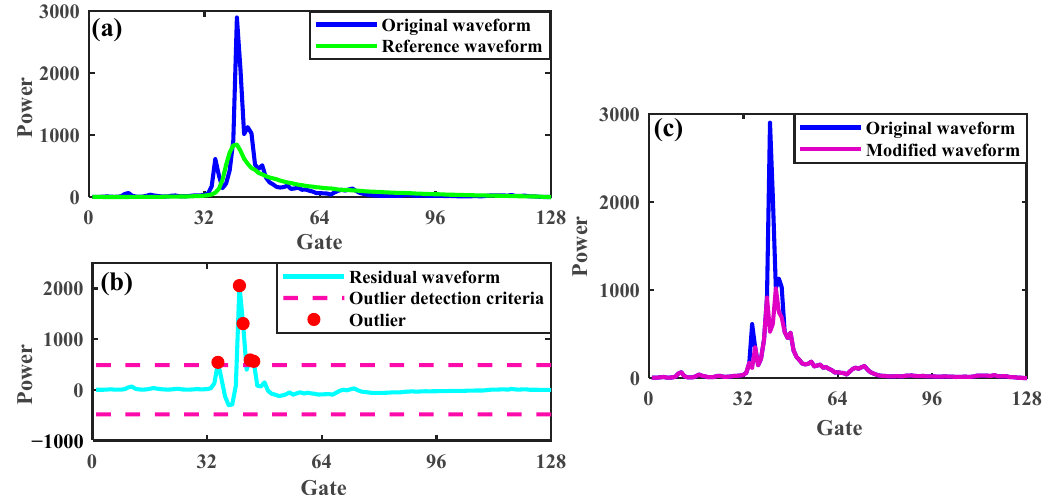
Figure 7. Waveform modification for a waveform in pass 25 of cycle 34 in the Persian Gulf ( a ) is the original waveform, ( b ) is the detected outlier powers, and ( c ) is the modified waveform.